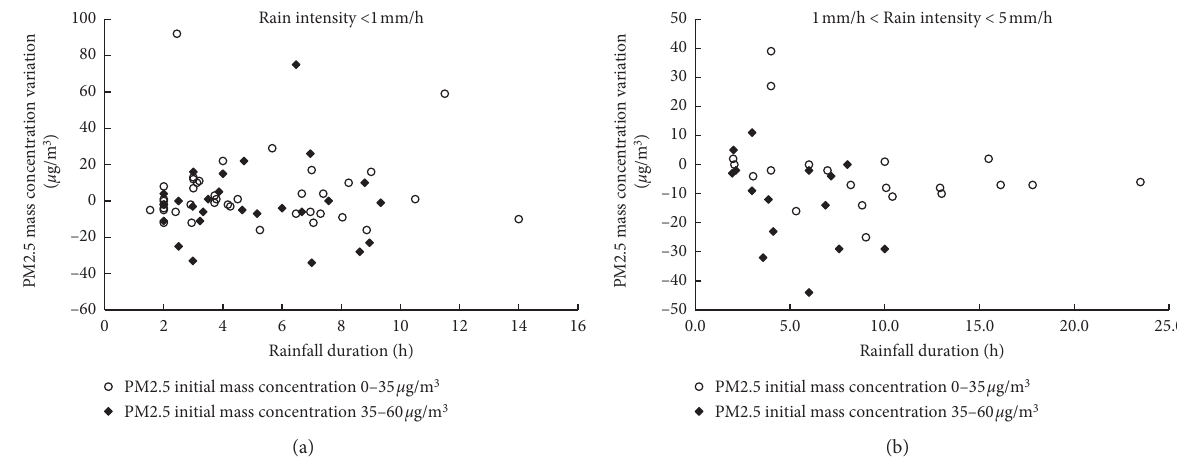
Figure 8: The relationship between mass concentration variation of PM2.5 and rainfall duration.